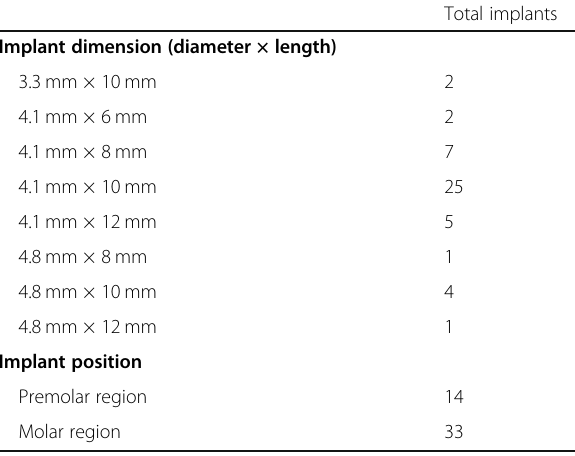
Table 2 Distribution of implant according to the dimension and region of insertion